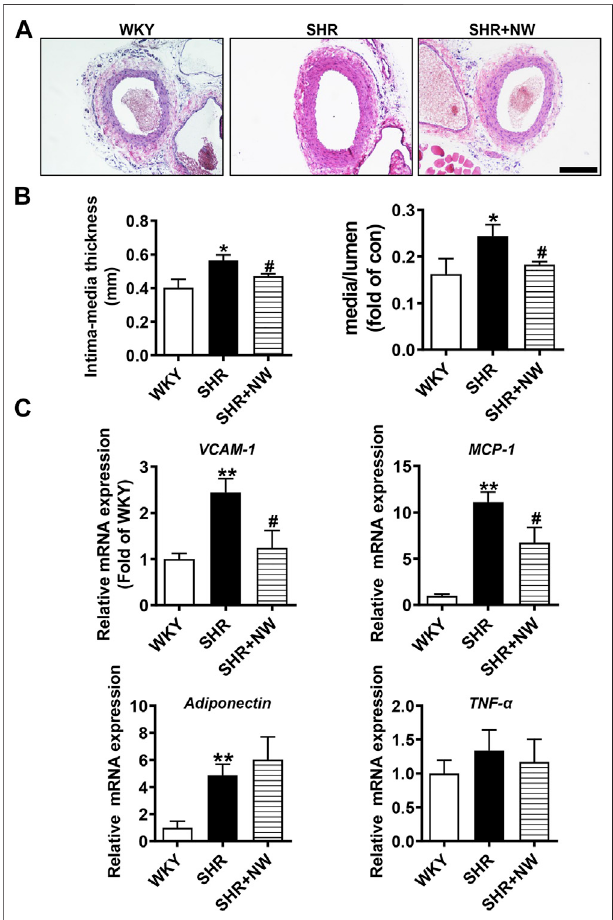
FIGURE 7 | NW treatment restrains vascular remodeling and vascular in fl ammation in SHRs. H&E staining of the femoral artery (A) , scale bar (cid:2) 100 μ m. Femoral artery intima media thickness and ratio of media to lumen (B) . Real-time PCR analysis of VCAM-1, MCP-1, adiponectin, and TNF- α mRNAlevels (C) .N (cid:2) 10/group.* Versus WKYrats, # versus SHRs.* p < 0.05, ** p <